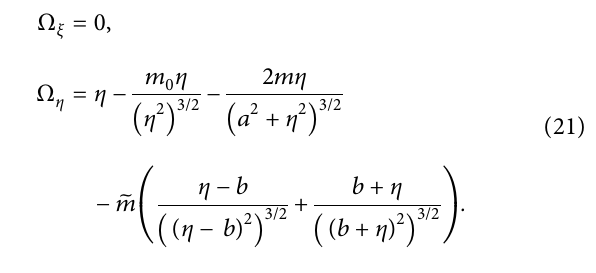
(green), 􏽥 m (orange), and m (blue) for different values of b 0